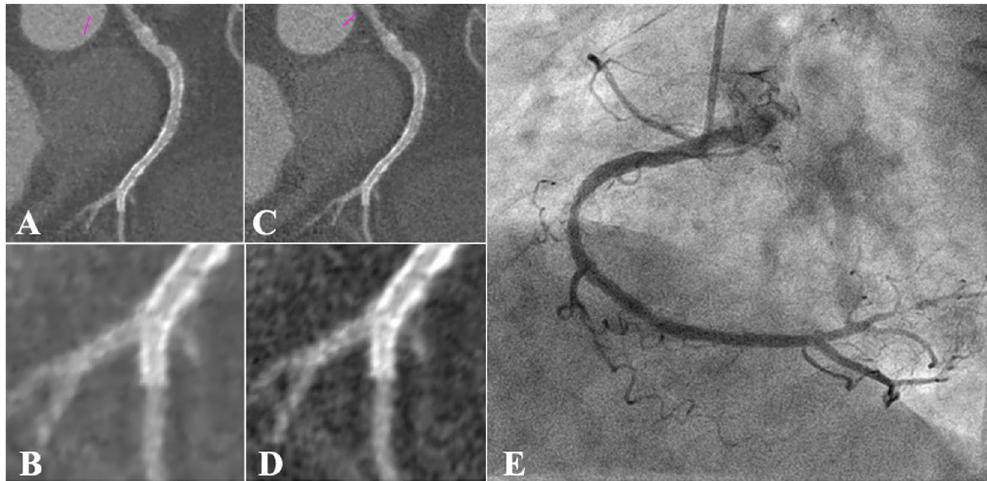
Figure 2. Example of the absence of in-Stent restenosis (2.75 mm Diameter Drug-Eluting Stent). (A) Sinogram affirmed iterative reconstruction dataset with curved multi-planar reconstruction of the RCA. It showed no significant in-stent restenosis especially in magnified scale (B , C ) Filtered back projection dataset with curved multi-planar reconstruction of the RCA. It showed uncertain in-stent patency even in magnified scale ( D , E ) Corresponding conventional coronary angiogram confirmed the absence of significant luminal narrowing within the stents.